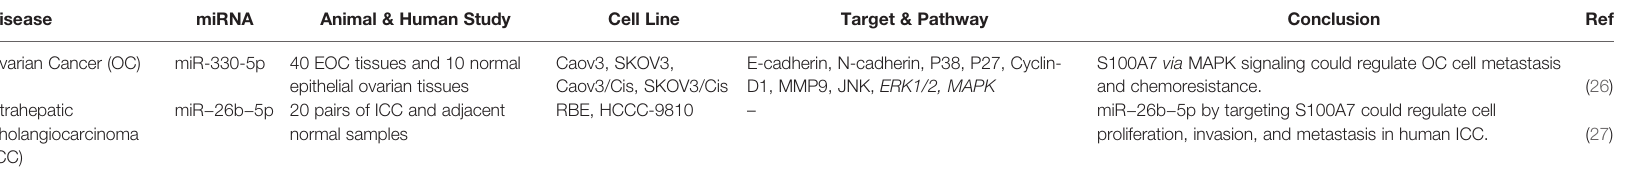
TABLE 5 | S100A7-interacting miRNAs.